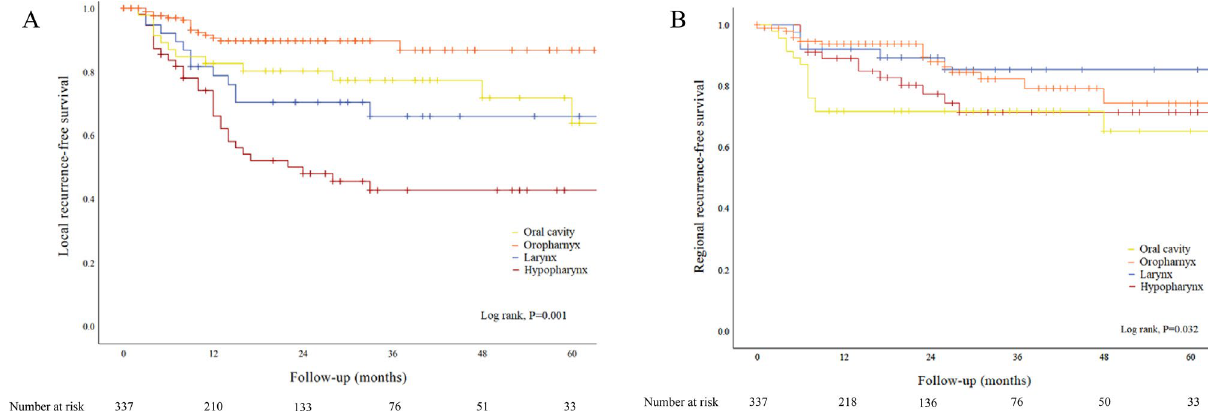
Figure 3. Kaplan–Meier analysis showing local recurrence-free ( A ) and regional recurrence-free survival ( B ) in patients according to primary tumor site, respectively. Both survival rates were different in a statistically highly significant manner (Log rank, P = 0.001 and P = 0.032, respectively).